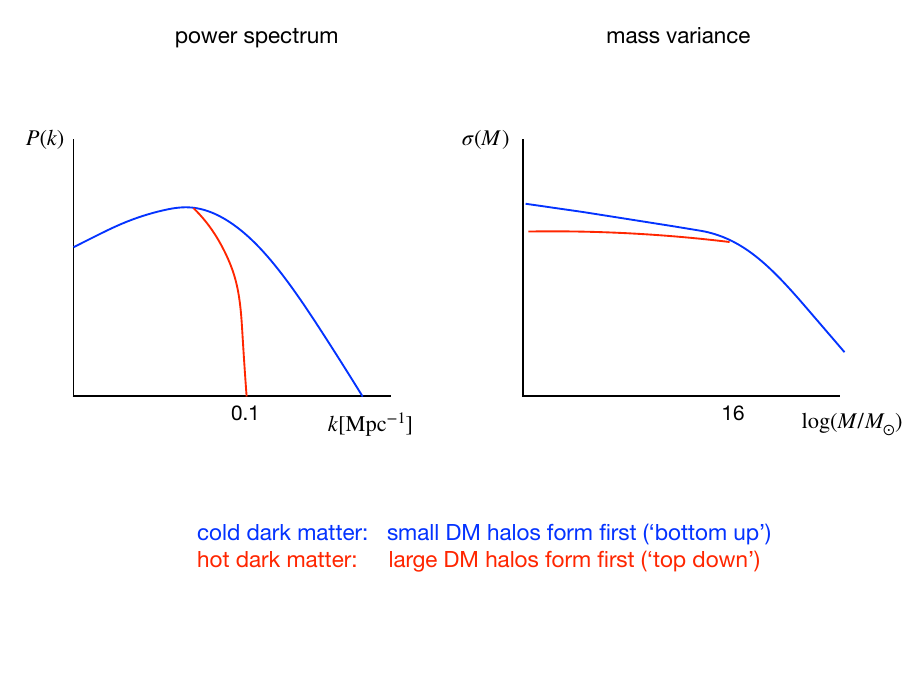
Figure 3: A sketch of the power spectrum, P ( k ) , (left) and mass variance, σ ( M ) , (right) for cold dark matter (blue) and hot dark matter